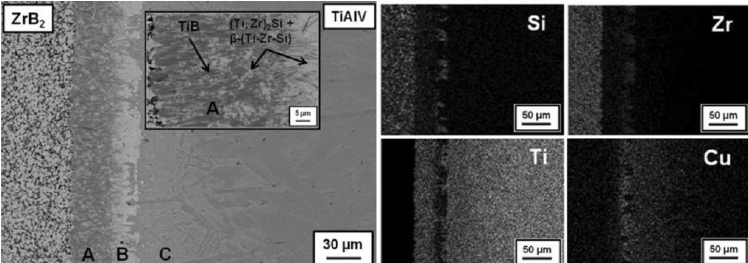
Figure 14. Schematic of the formation of each reaction layer during the brazing process: ( a – c ) show the interaction between filler and base metal; ( d ) the filler begins to melt; ( e ) the molten brazing alloy wetted the surface of base metals; ( f ) the formation of Ti 5 Si 3 and TiC; ( g ) the formation of TiB and TiB 2 ; ( h ) the formation of Ti 2 Cu and TiCu; ( i ) the formation of (Ti,Zr) 2 (Cu,Ni) and β -Ti during the cooling process, reproduced from Reference [39] with permission of Elsevier, 2017. ZrC-SiC is another ultra high temperature ceramic that, due to the outstanding properties, is an ideal candidate for structural applications, such as rocket engines, structural components or diffusion barriers in the nuclear industry. However, the joining of this ceramic to metallic parts is essential for